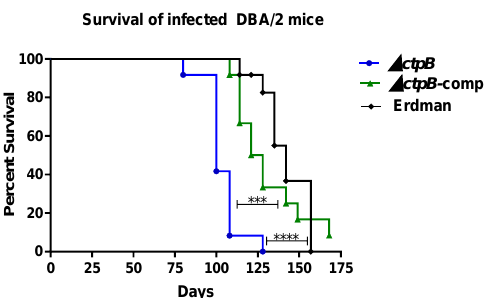
Figure 5. Deletion of ctpB from M. tuberculosis increases virulence in DBA/2 mice. Shown are Kaplan– Meier curves for relative survival of DBA/2 mice intravenously infected with the M. tuberculosis ctpB mutant ( ∆ ctpB ), parent strain Erdman, or complemented mutant ( ∆ ctpB -comp). When moribund, animals were euthanized. Log-rank (Mantel–Cox) test was used to assess significant differences between groups (*** p < 0.001, **** p <